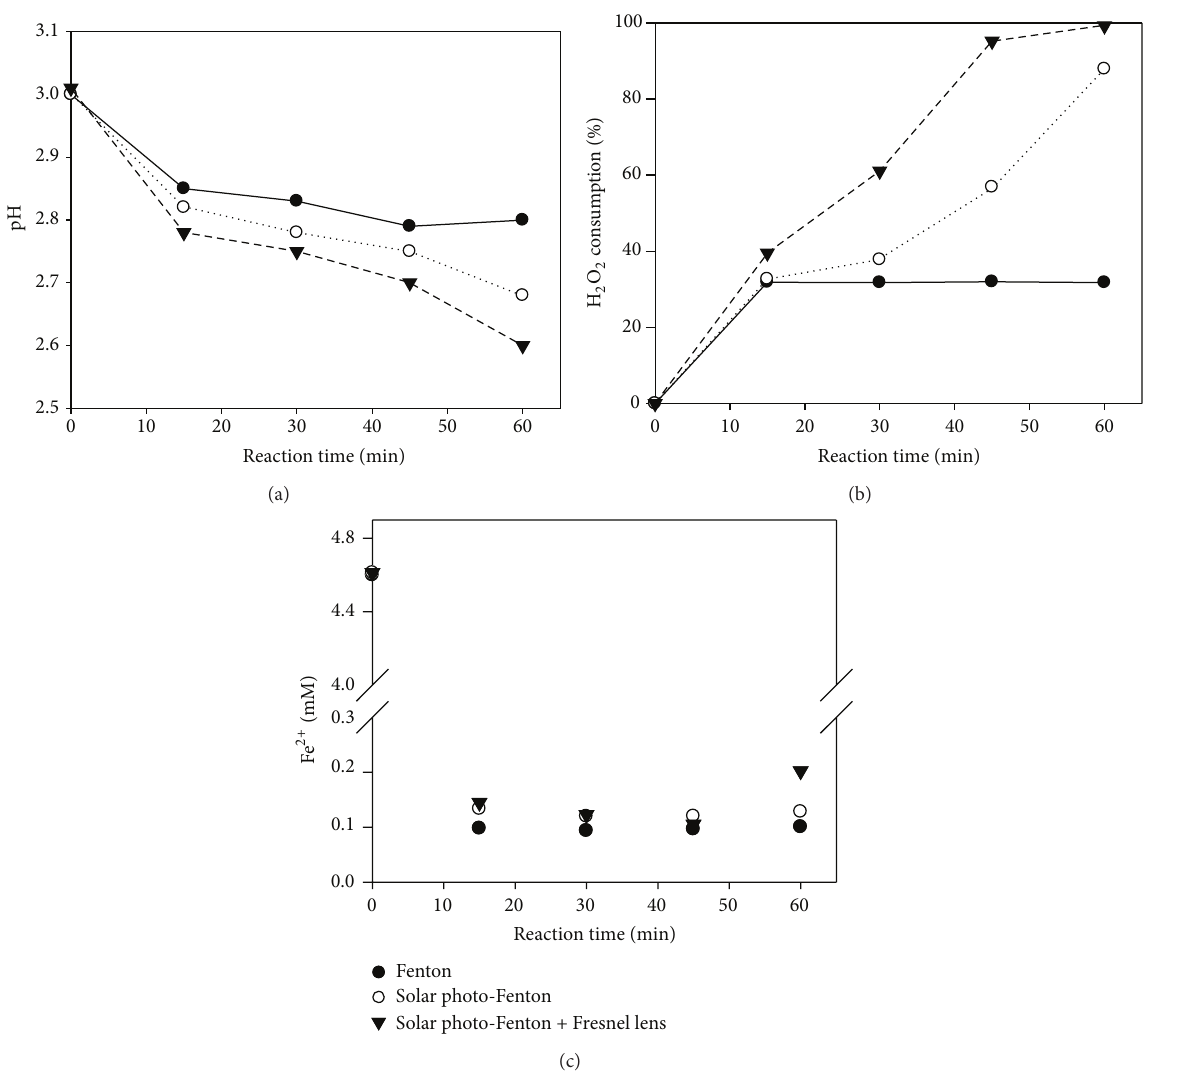
Figure 2: Effect of Fresnel lens on the pH, H 2 O 2 consumption, and residual Fe 2+ concentration in the electro-optical industry wastewater treated by solar IPCC reactor (initial pH: 3.0; [H 2 O 2 ] 0 /COD 0 = 2.0 g/g; [H 2 O 2 ] 0 /[Fe 2+ ] 0 = 7.5).